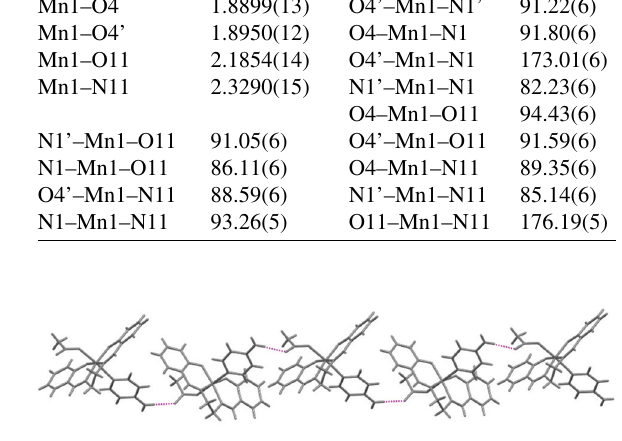
Figure 2. One-dimensional infinite chain of [ Mn(ac)(4-apy)(sal) ] , 1 . Hydrogen bonds of N-H···O type are drawn as violet dashed lines.